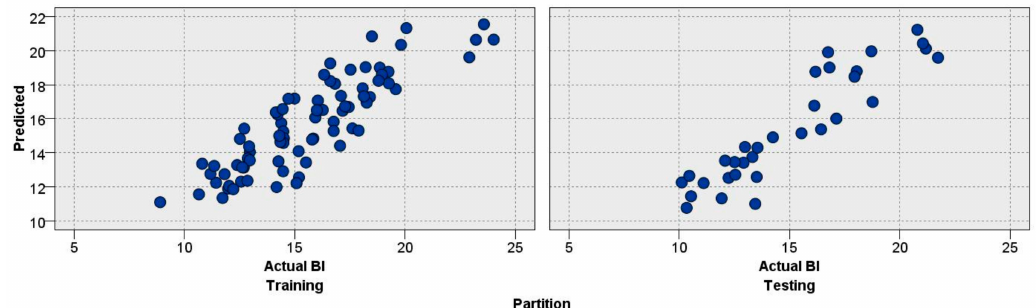
Figure 9. Testing and training results of ANN model to predict the BI .